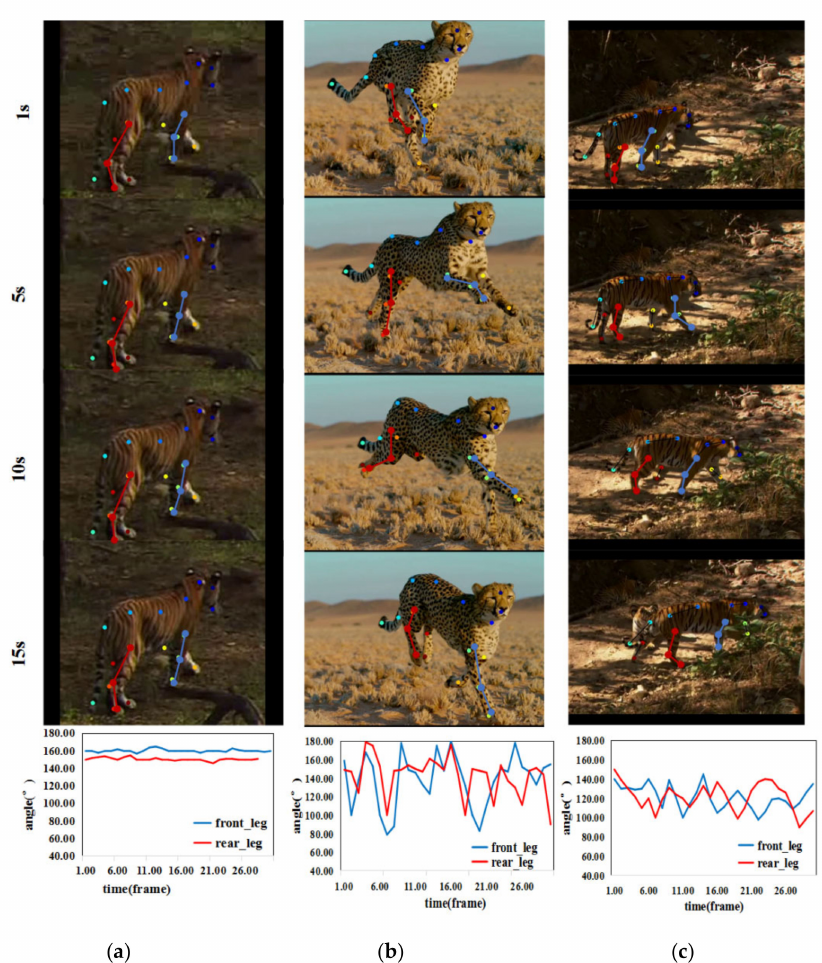
Figure 7. Video representative frames and variation in the bending angle: from the first row to the fourth row are video representative frames of three upright actions and the fifth row is the variation curves of the bending angles (blue and red represent the variation curves of the front legs and hind legs, respectively) for ( a ) standing, ( b ) galloping, and ( c )